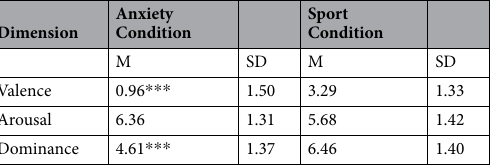
Table 1. Emotions expressed by the sweat donors (n = 28) using the Self-Assessment Manikin (state measure). Valence: range − 4 to + 4, Arousal: range 1 to 9, Dominance: range 1 to 9, *** p < 0.001 (difference between anxiety and sport condition, Bonferroni